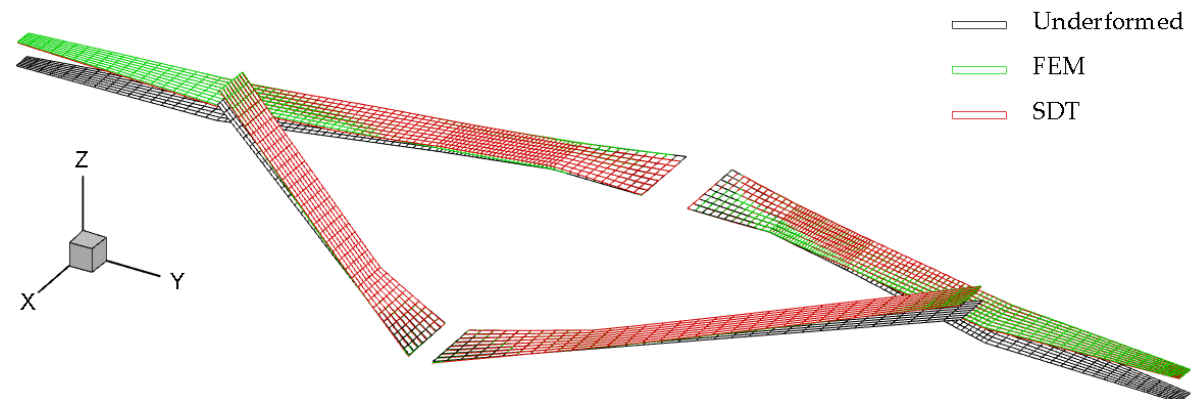
Figure 15. Deformed configuration obtained from FEM and SDT at the beginning of the test.